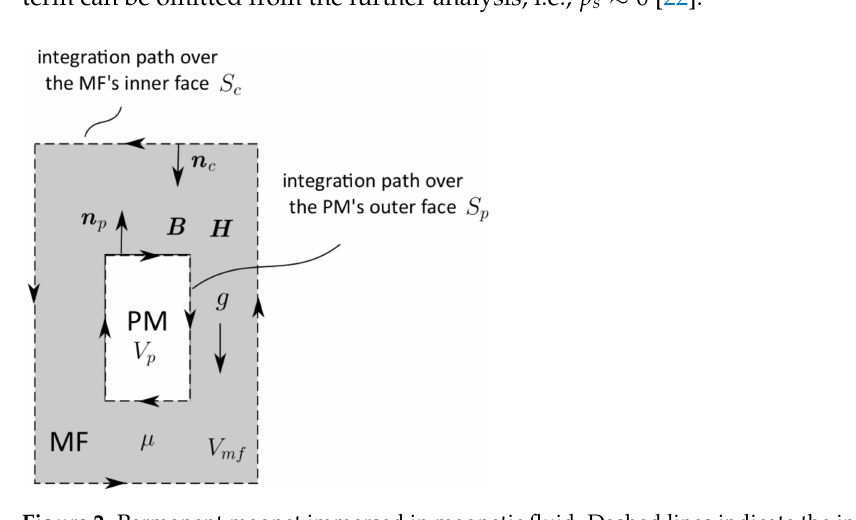
Figure 2. Permanent magnet immersed in magnetic fluid. Dashed lines indicate the integration paths over the container’s inner surface S c and PM surfaces S p ,